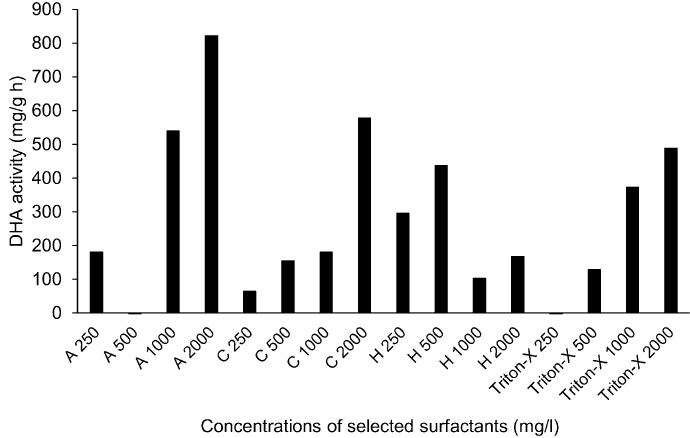
Figure 3. The dehydrogenase activity (DHA, mg/(g h)) of different concentrations (indicated by number in the label, mg/L) of surfactants (identified by letter in the label).